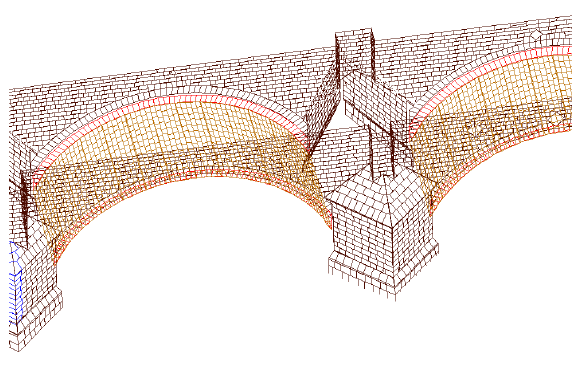
Figure 5. 3D model of Charles Bridge in Prague.